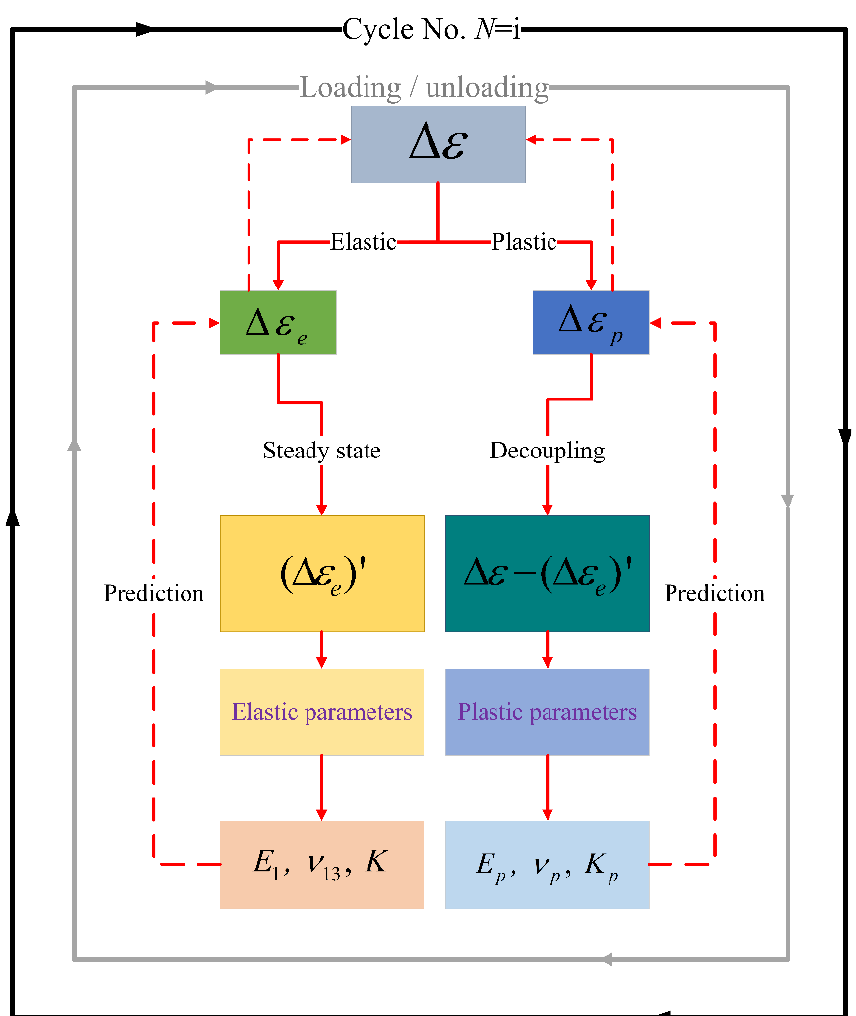
Figure 4. Flow chart of the decoupling method .